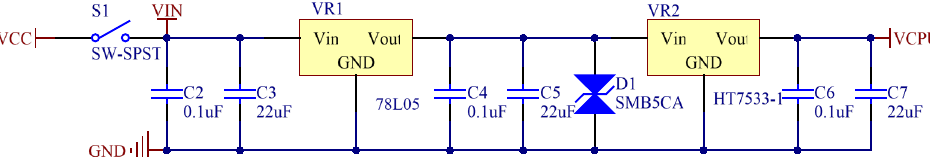
Figure 10. Power module circuit diagram.